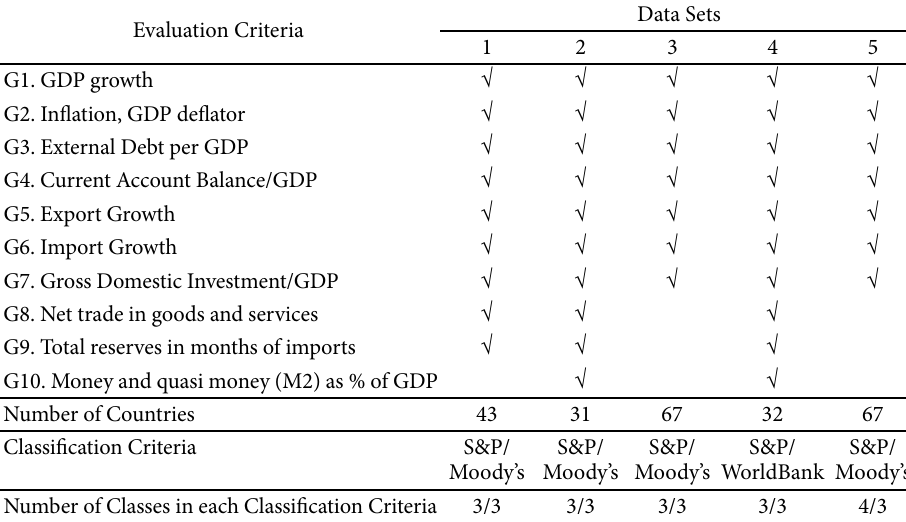
table 7. Main characteristics of the data